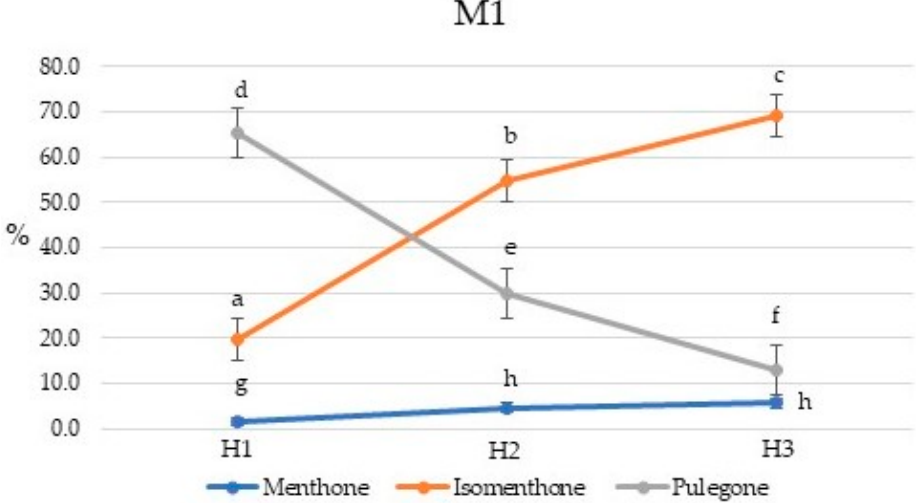
Figure 4. Seasonal variation in the menthone, isomenthone, and pulegone percent concentrations for Pycnanthemum virginianum variety M1. Percent concentrations with same letter are not significantly different at p ≤ 0.05. H1, H2, and H3 are harvest times, 135, 155, and 170 days after planting, respectively.